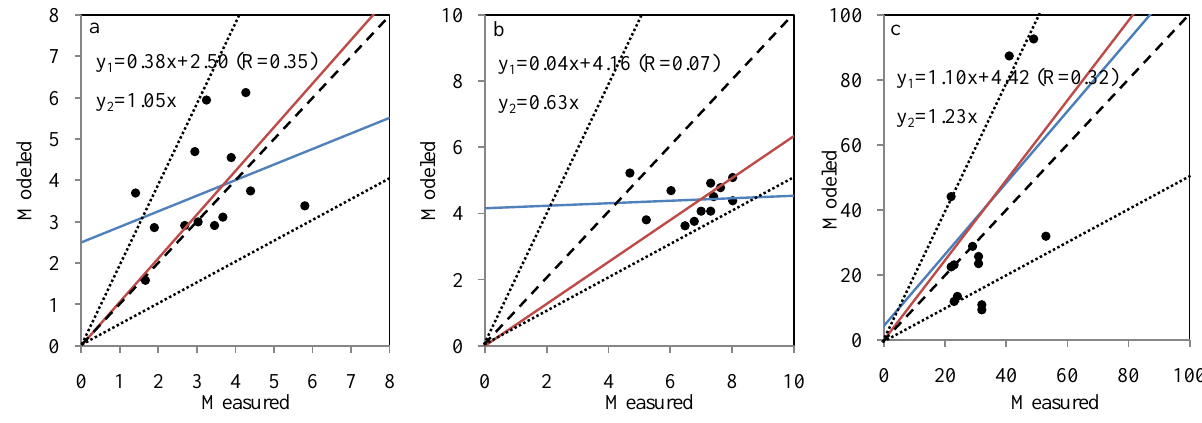
Fig. 4. Comparison of simulated concentrations of NH + in precipitation (a) , NO − in precipitation (b) and NO 2 in air (c) with measured data (units for NH + and NO − are mgL − 1 ; unit for NO 2 is µgm − 3 ) . (The dotted lines are 1:2 and 2:1 fit line, and the dashed line is 1:1 fit line. The red and blue solid lines are linear fit of zero intercept and non-zero intercept regressions, respectively.) A model is considered fit for purpose if more than 50% of the points fall within the 1:2 and 2:1 lines.